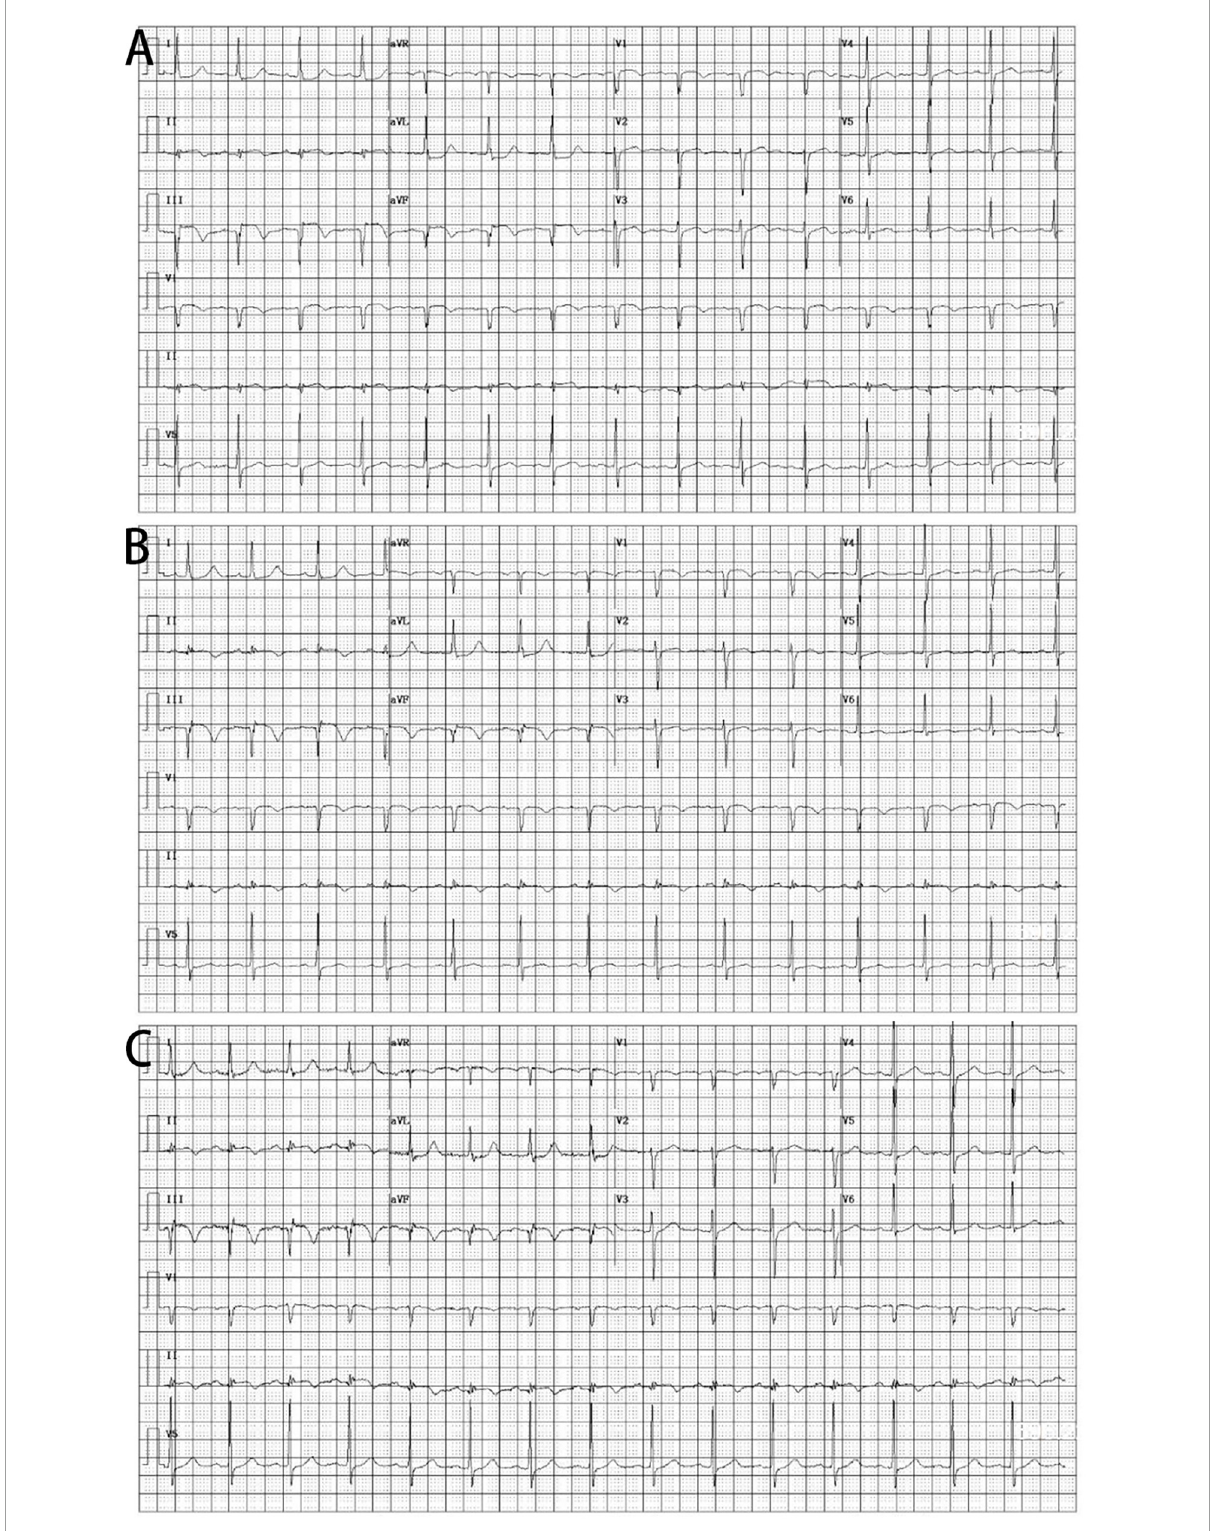
FIGURE1 Electrocardiograms. (A) In the emergency room. (B) After intracoronary artery retrograde thrombolysis (ICART). (C) 7 days after